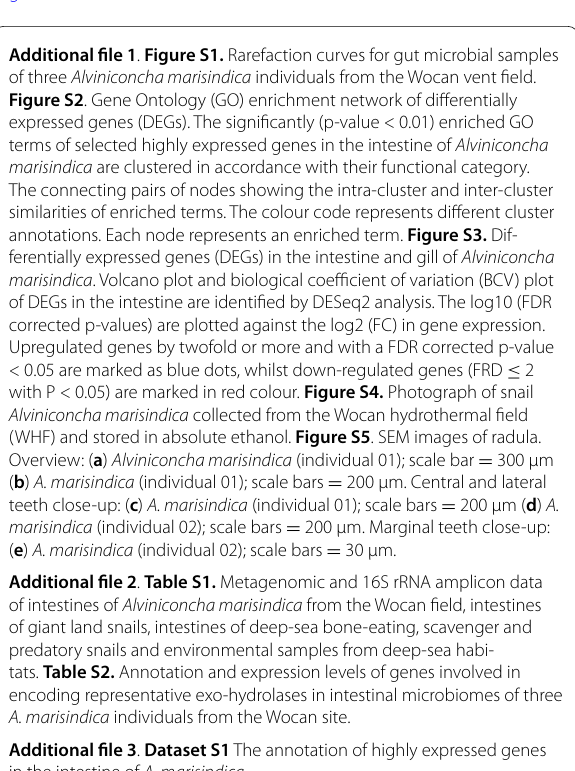
Additional file 2 . Table S1. Metagenomic and 16S rRNA amplicon data of intestines of Alviniconcha marisindica from the Wocan field, intestines of giant land snails, intestines of deep‑sea bone‑eating, scavenger and predatory snails and environmental samples from deep‑sea habi‑ tats. Table S2. Annotation and expression levels of genes involved in encoding representative exo‑hydrolases in intestinal microbiomes of three A. marisindica individuals from the Wocan